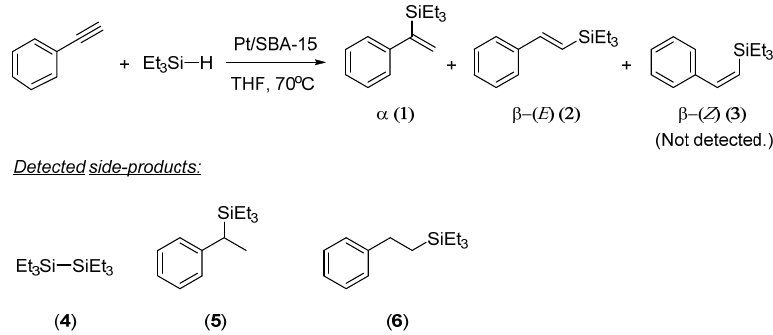
Figure 5. Hydrosilylation of phenylacetylene with triethylsilane leading to vinylsilanes 1 and 2 and the detected side products 4 – 6 .